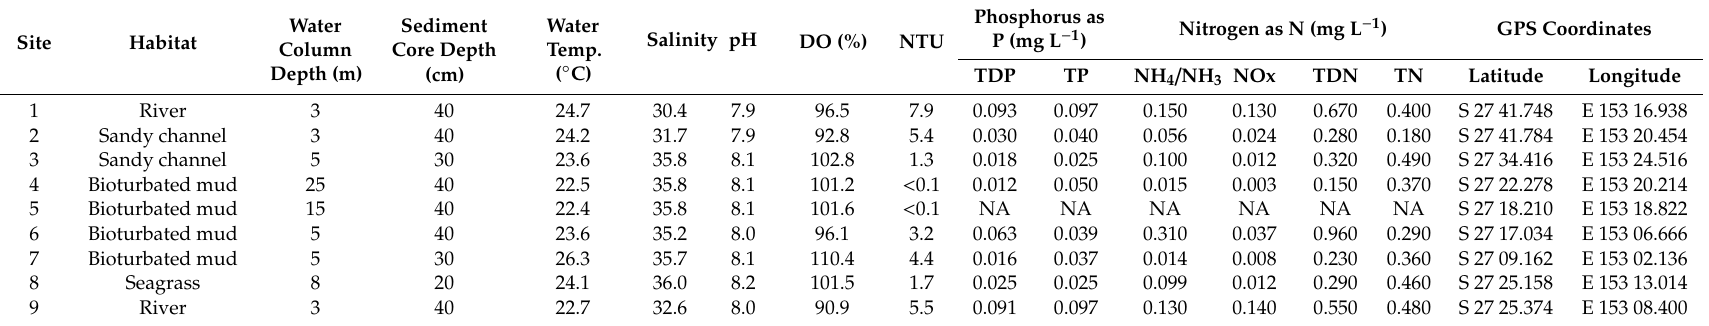
Table 1. Summary of characteristics of each sampling site and the discrete measurements collected in-situ (average over 5 min, continuous